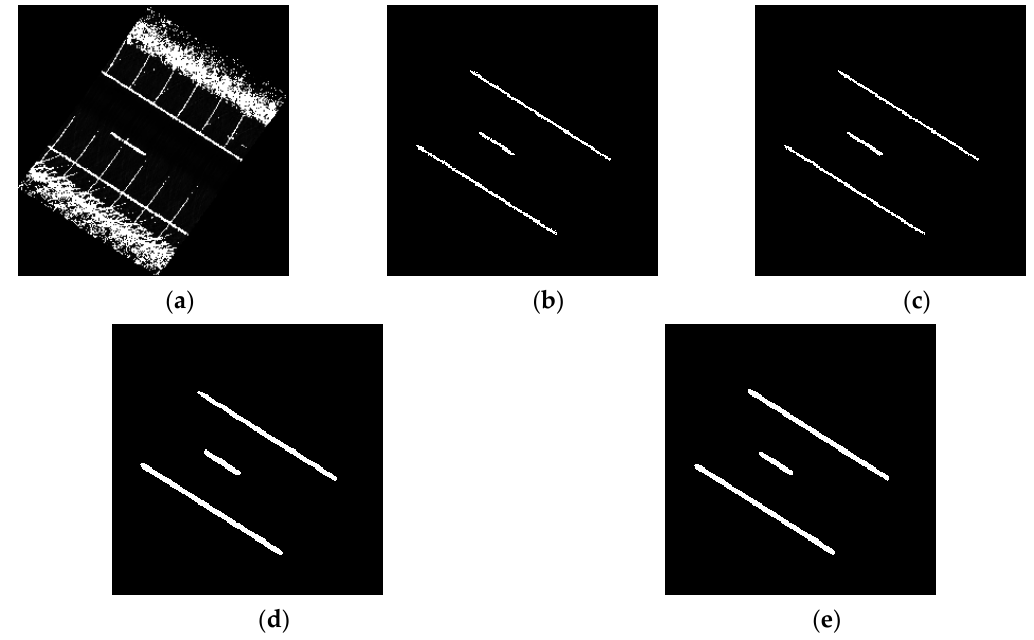
Figure 25. Asphalt pavement area (for location i in Figure 24): ( a ) original intensity image and predicted lane marking images from ( b ) original intensity thresholding, ( c ) normalized intensity thresholding, ( d ) U-net model 1, and ( e ) U-net model 2.